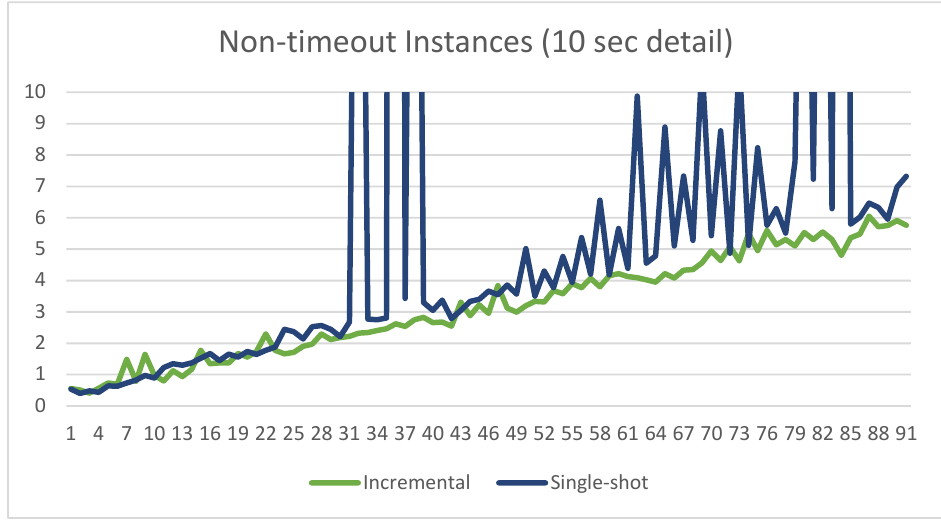
Figure 3. Comparison of the execution times for all instances that did not time out.